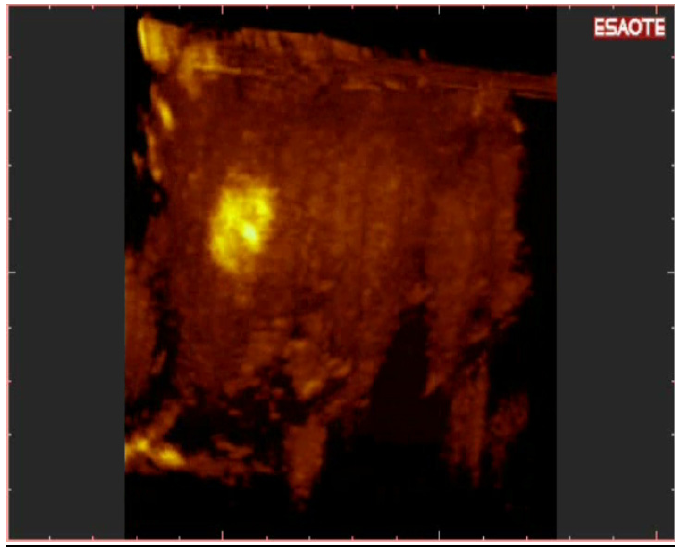
Figure 7. Detection of new HCC: A new HCC was detected during follow-up: 3-D NAV CEUS was able to show the exact position of the nodule in tridimensional space.